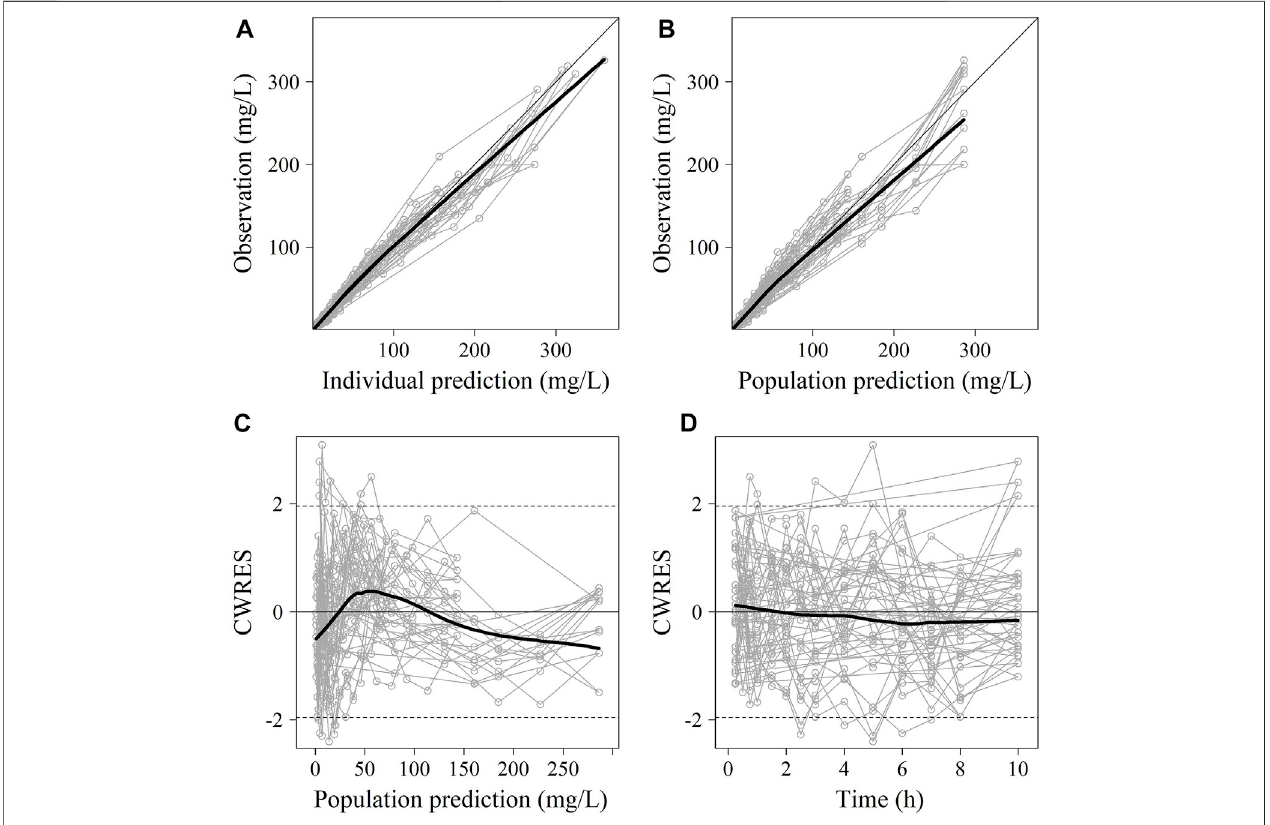
FIGURE 1 | The goodness-of- fi t plots of cefoperazone Pop-PK model. (A) Relationship between observed versus IPRED of PK; (B) Relationship between observed versus PRED of PK; (C) CWRES at different PRED; (D) CWRES at different time points. CWRES: conditional weighted residuals; PRED: predicted value; IPRED: individual predicted value. The thin solid lines represent the x = y lines. The thick solid lines are the trend lines.